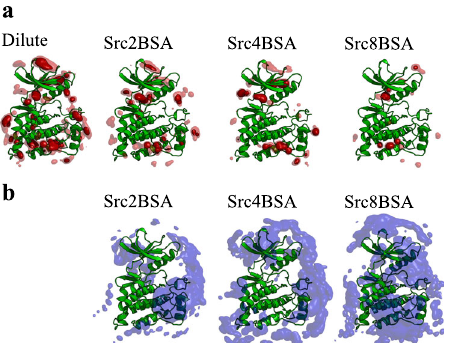
Fig. 1 Decrease of non-canonical PP1-binding sites upon crowding. Spatial distribution functions (SDF) of a PP1 and b BSA around c-Src kinase. In the case of BSA-SDF, C α atoms are used for analysis. The PP1-SDF is shown as isosurface at 0.5% (transparent) and 1.5% occupancies (solid). For BSA- SDF, the isosurface at 1.0% occupancy is shown.